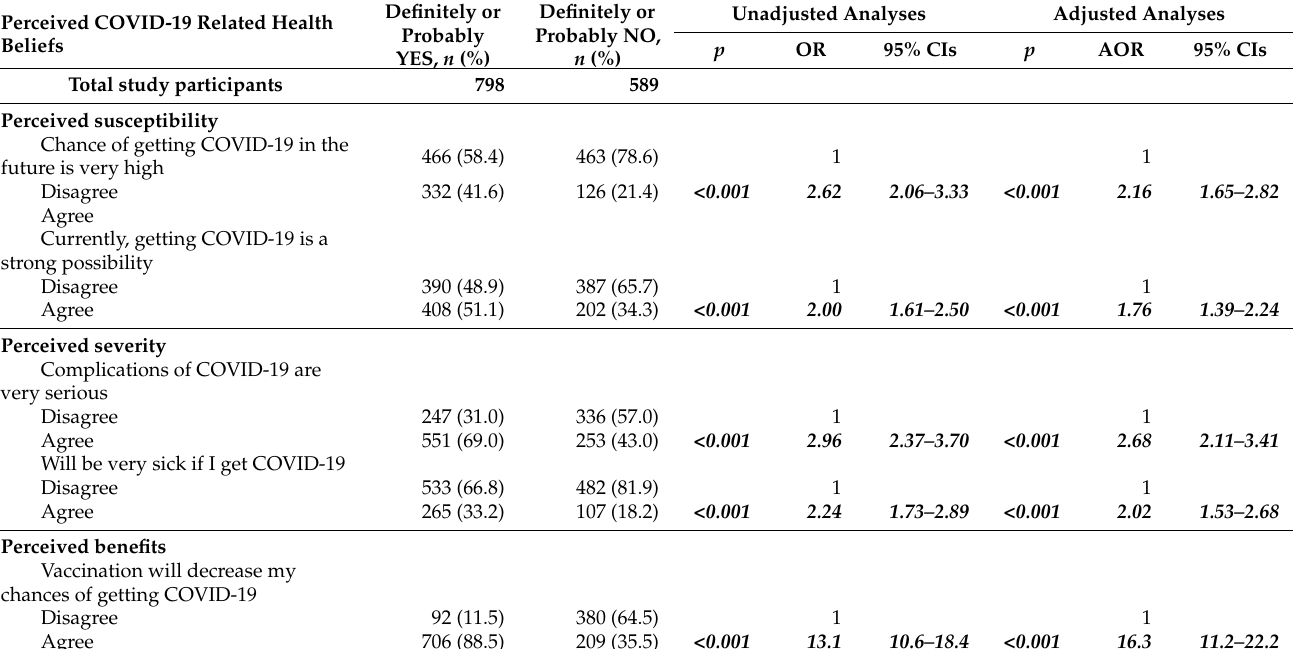
Table 4. Association between COVID-19 related health beliefs and intention to receive a COVID-19 vaccine in the KSA, February–March